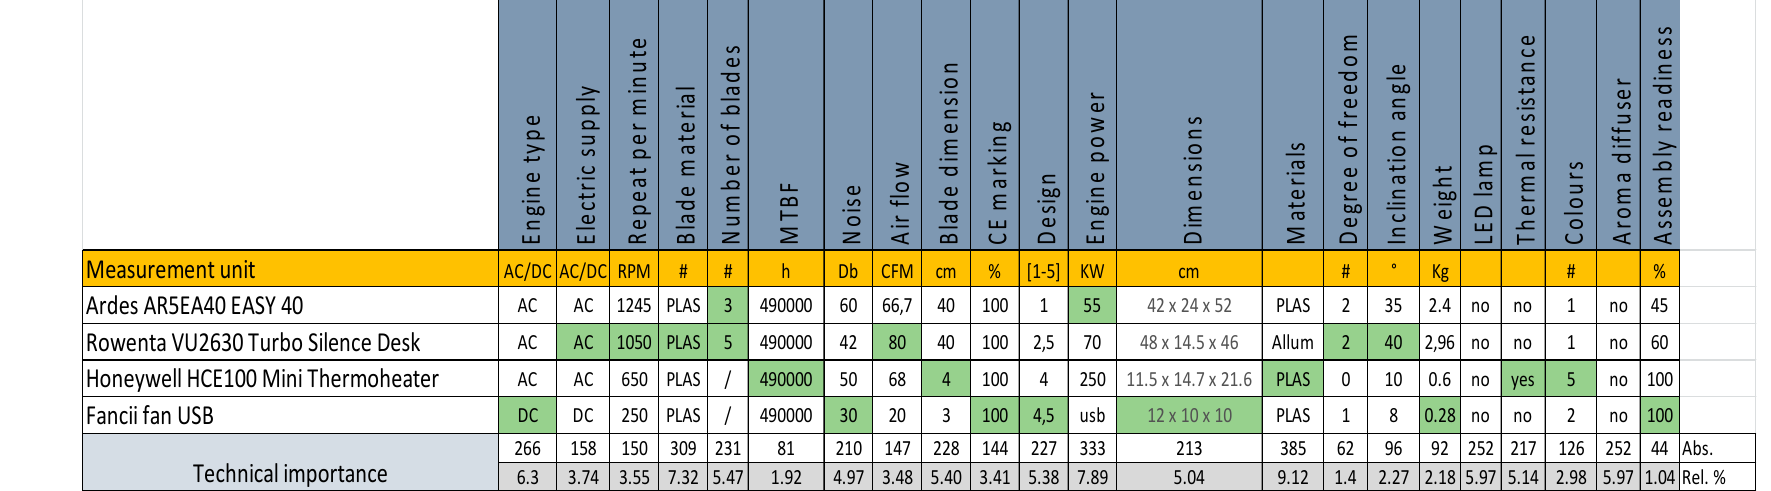
Figure 9. Technical benchmarking.